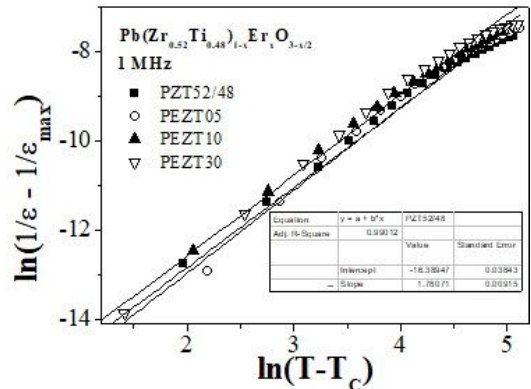
) vs . ln( T – T c) of PZT and max .